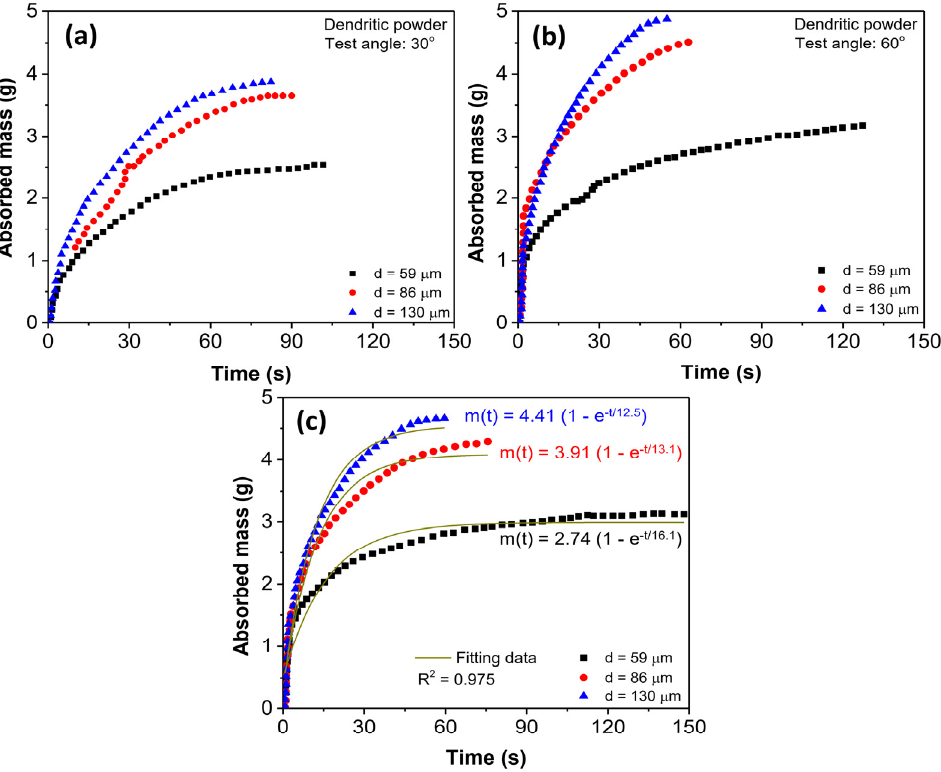
Figure 11. Amount of absorbed water of porous copper samples using dendritic powder at three different angle positions ( a ) 30°, ( b ) 60°, and ( c ) 90° with predicted results.